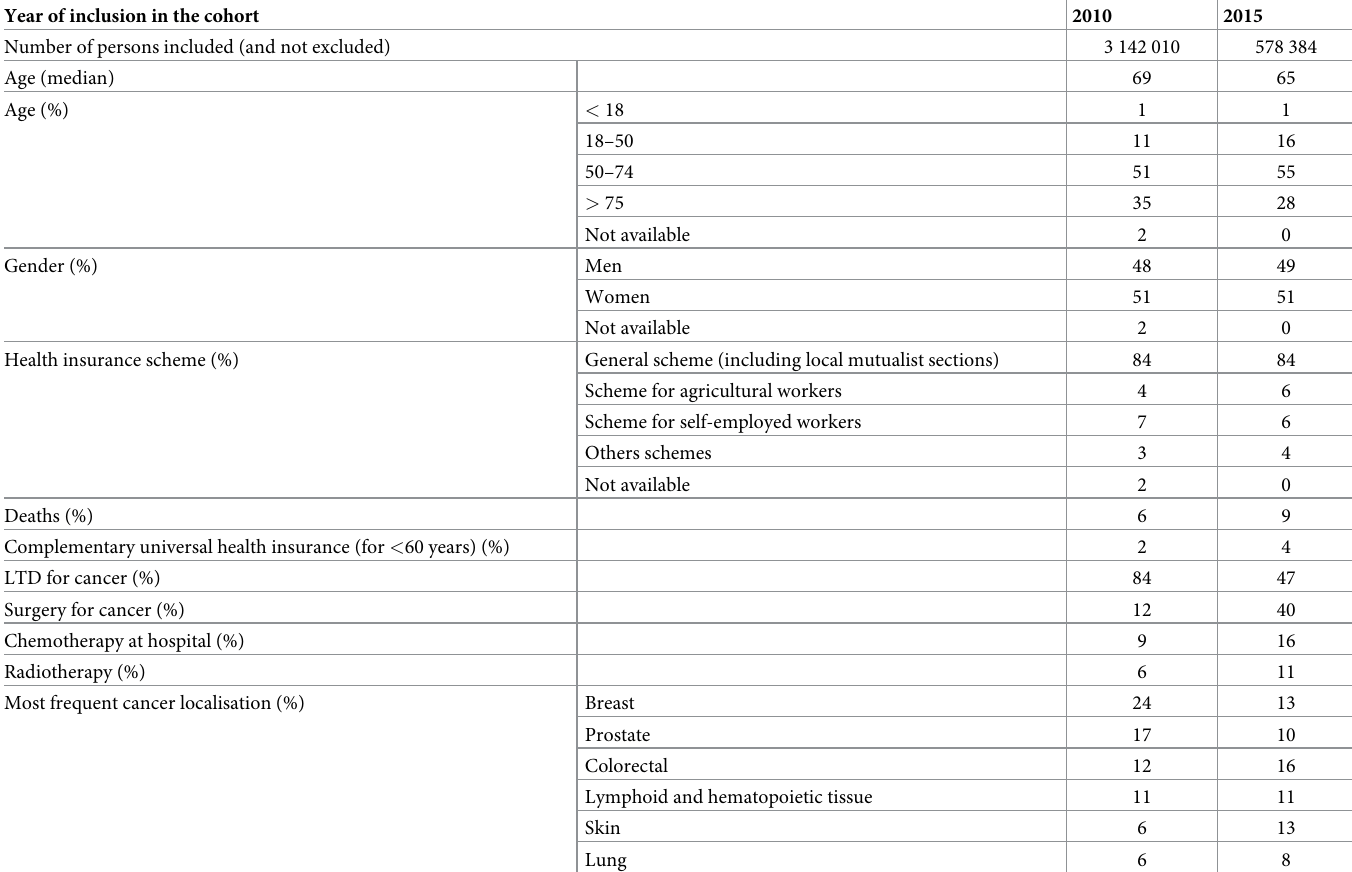
Table 1. Characteristics of subjects benefiting from cancer-related healthcare in 2010 and